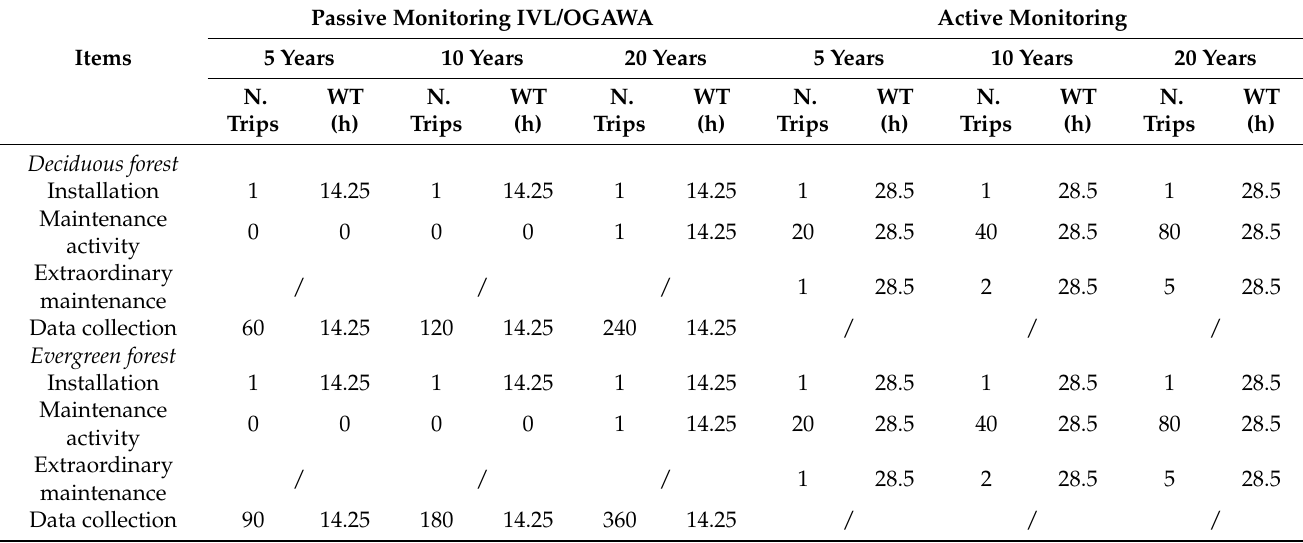
Figure 1. Schematic representation of passive ( a ) and active ( b ) ozone monitoring stations. The passive station shows an IVL O 3 sampler, the active station shows a model 106-L (2B Technologies, Inc., Boulder, CO, USA) O 3 sensor. Table 1. Number of trips and work time (WT) for each trip from the central station to the forest site for two case studies at a similar distance from the station, i.e., evergreen Mediterranean (EF) and deciduous (DF) forests, and three time windows, i.e., 5, 10, and 20 years of monitoring. Simulations are based on the data collected during the 5-year project MOTTLES [29]. Passive Monitoring IVL/OGAWA Active